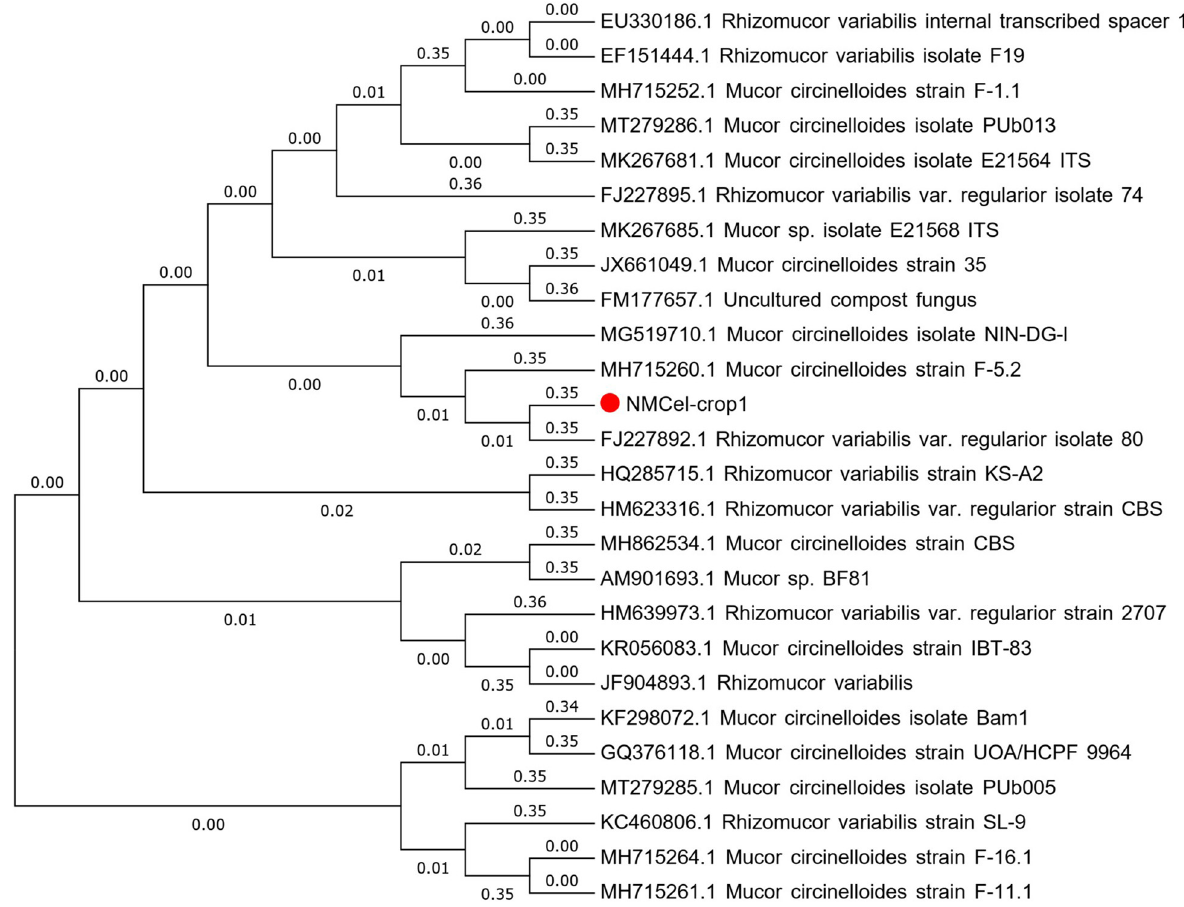
FIGURE 3 | Phylogenetic Minimum-Evolution (ME) tree of NMCel-crop1 and its related strains.